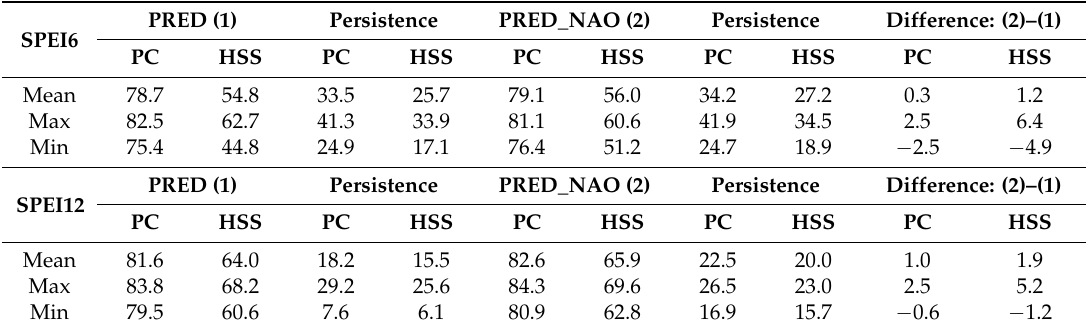
Table 10. As in Table 9 but relative to all months and SPEI6 (above) and SPEI12 (below).